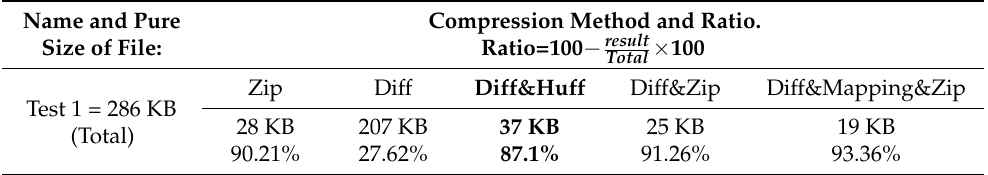
Table 1. Comparison between different compression methods–source file is 286 KB. Name and